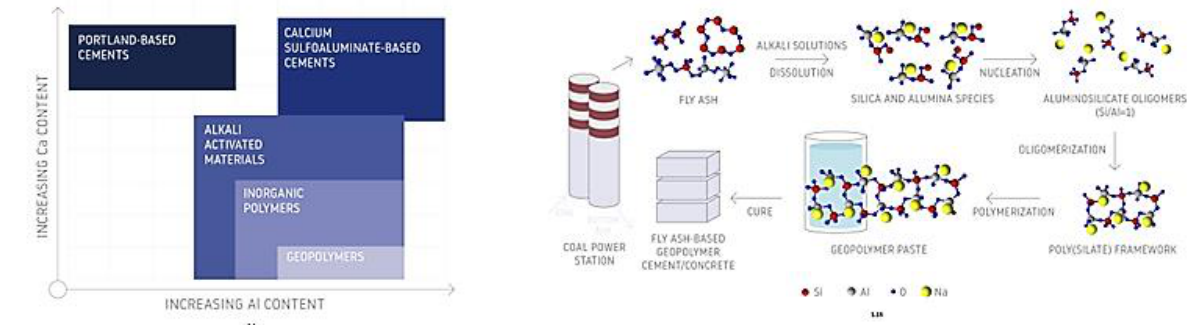
Figure 1. Process used for making geopolymers (adapted from [6]) and a schematic summary of the chemical relationships between geopolymers and other binders (adapted from [9]).